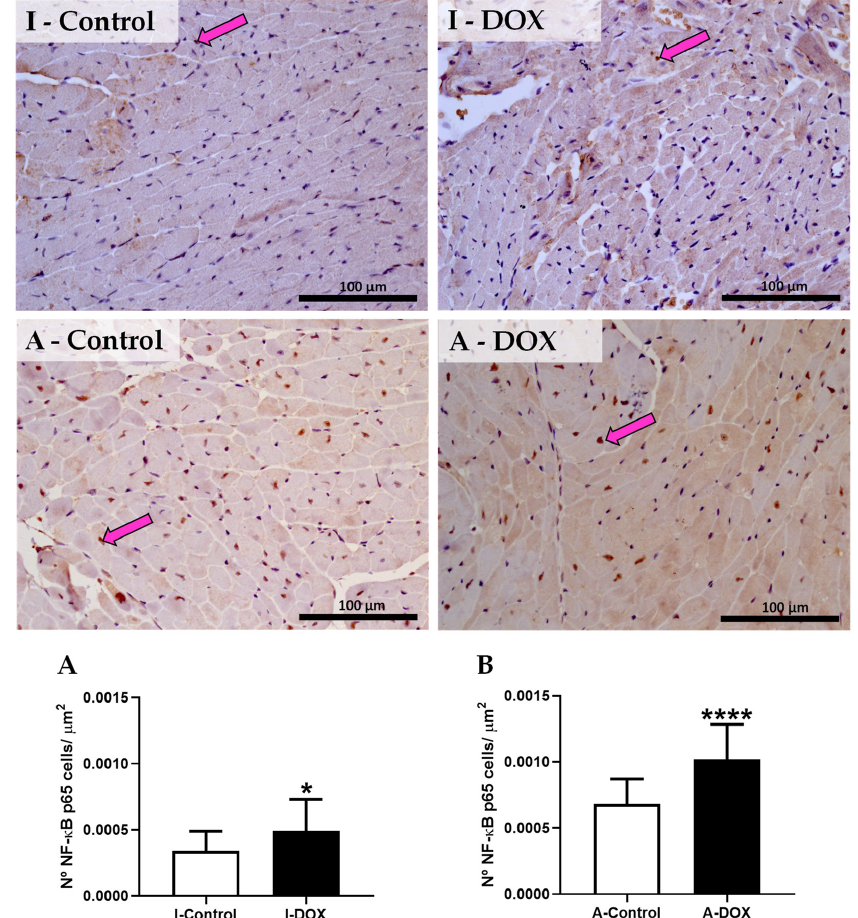
Figure 8. Representative photomicrographs of the immunohistochemistry determination of nuclear factor kappa B (NF- κ B) in the cardiomyocytes-like cells from infant DOX-treated (I-DOX) and control mice (I-Control), and adult mice exposed to a cumulative dose of 18.0 mg/kg DOX (A-DOX) and the respective controls (A-Control). Number of cells staining as positive, indicated by pink arrows for the activated NF- κ B of the heart of DOX-treated and control groups, in ( A ) infant and ( B ) adult animals. The results were expressed according to the number of positive cells per area ( µ m 2 ) as mean ± SD. Results were obtained from three animals from each treatment group. Statistical comparisons were made using the Mann–Whitney test: * p < 0.05, **** p < 0.001, DOX vs. control. Scale bar = 100 µ m, n = 3 (six random fields per n ). Images were taken at 40 ×